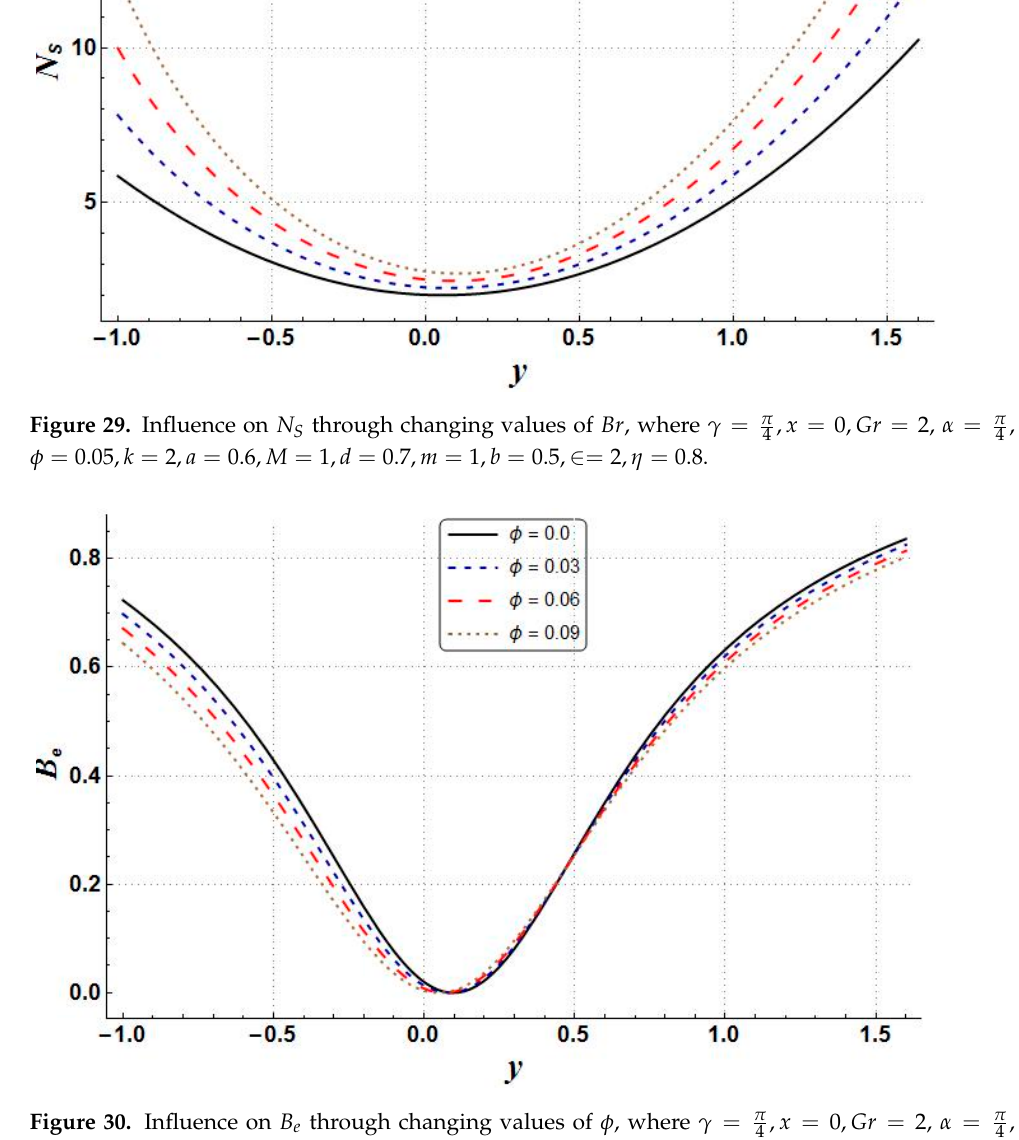
B through changing values of